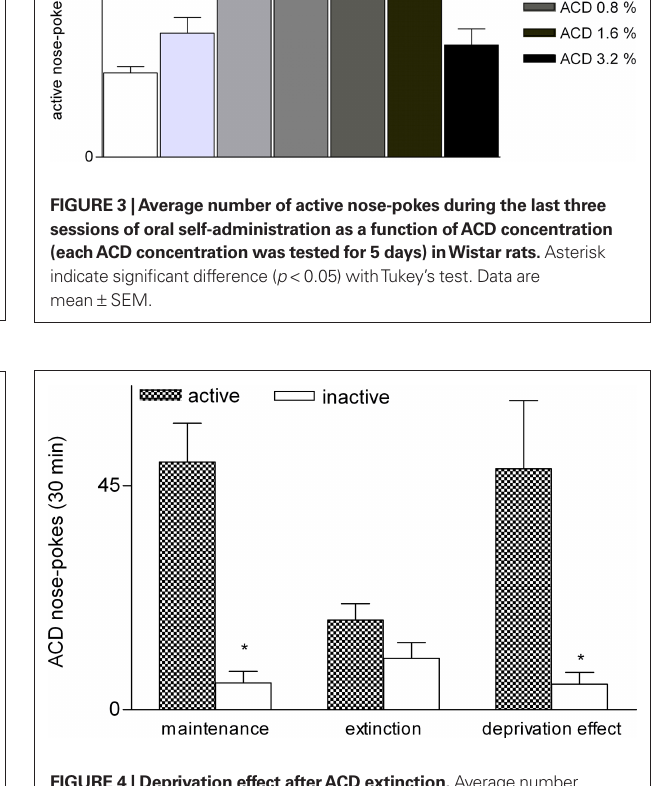
Figure 4 | Deprivation effect after ACD extinction. Average number (mean ± SEM) of active and inactive nose-pokes during five sessions of oral self-administration. Asterisk indicate significant difference ( p <